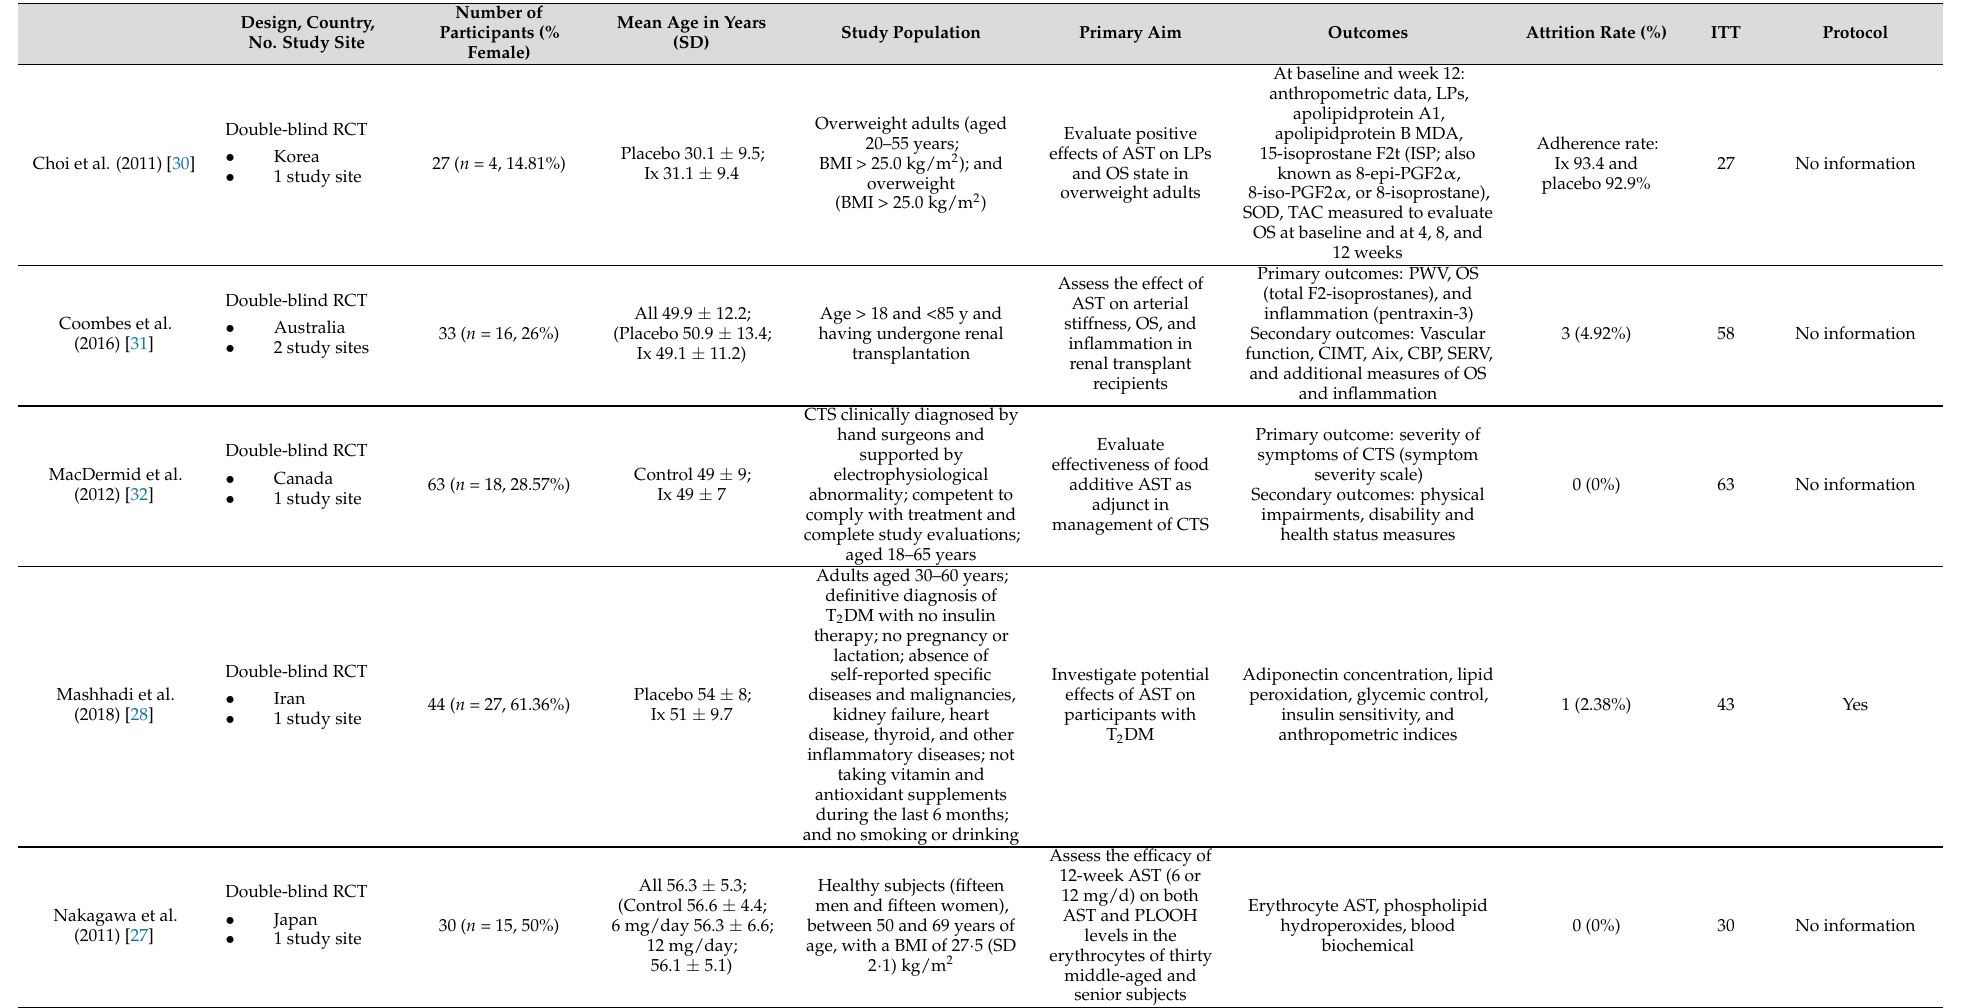
Table 2. Review characteristics of included studies ( n =